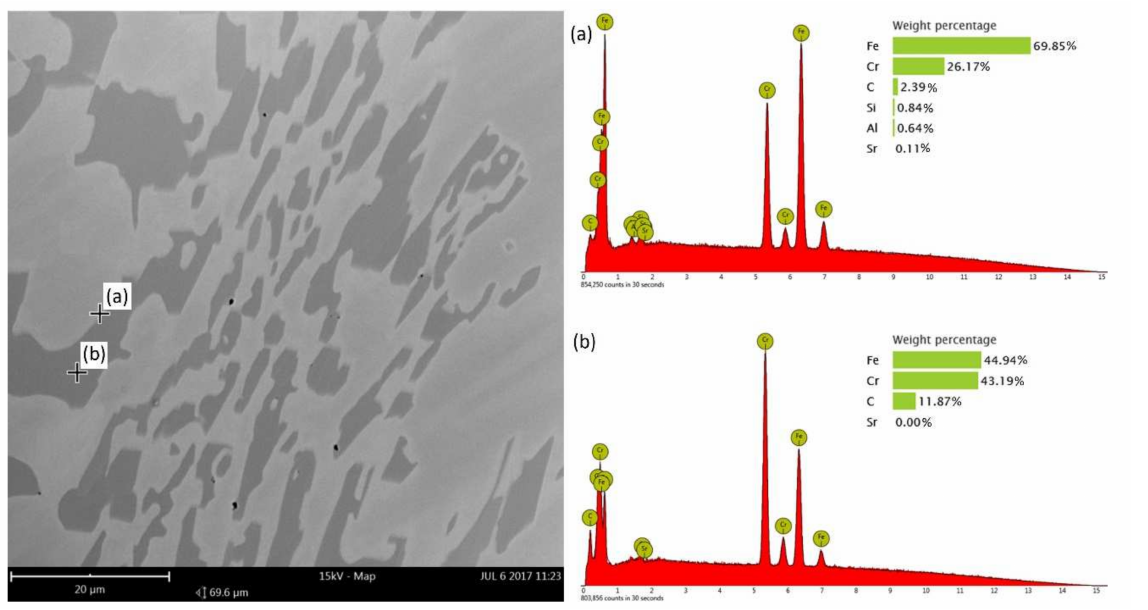
Figure 8. EDS point analysis on the border austenite–chromium carbide ( a ) and inside carbide ( b ) in Sr005 sample, SEM.